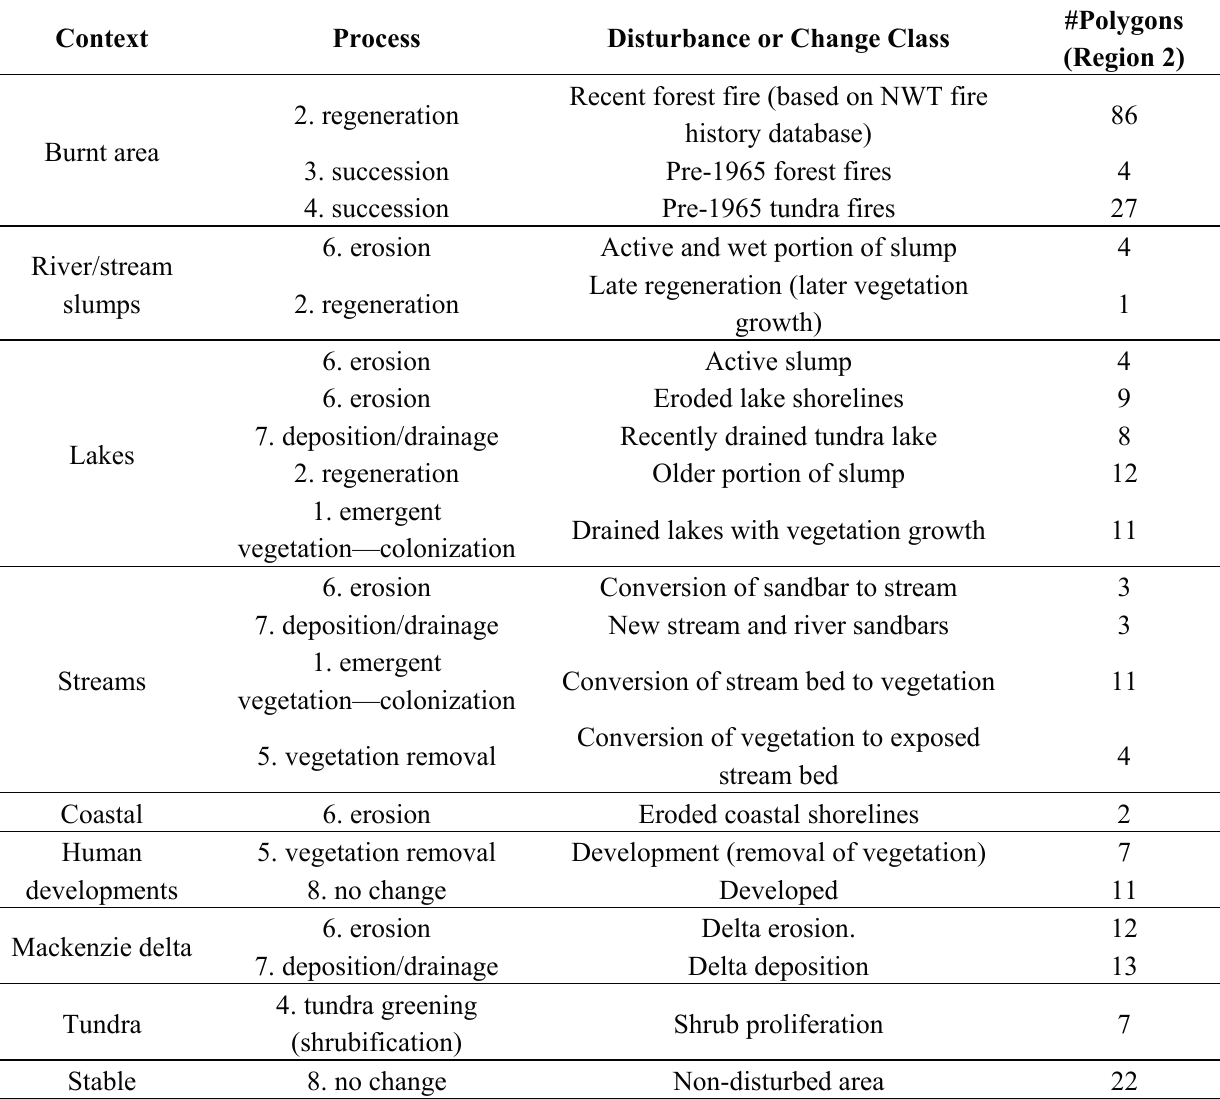
Table 2. Disturbance class